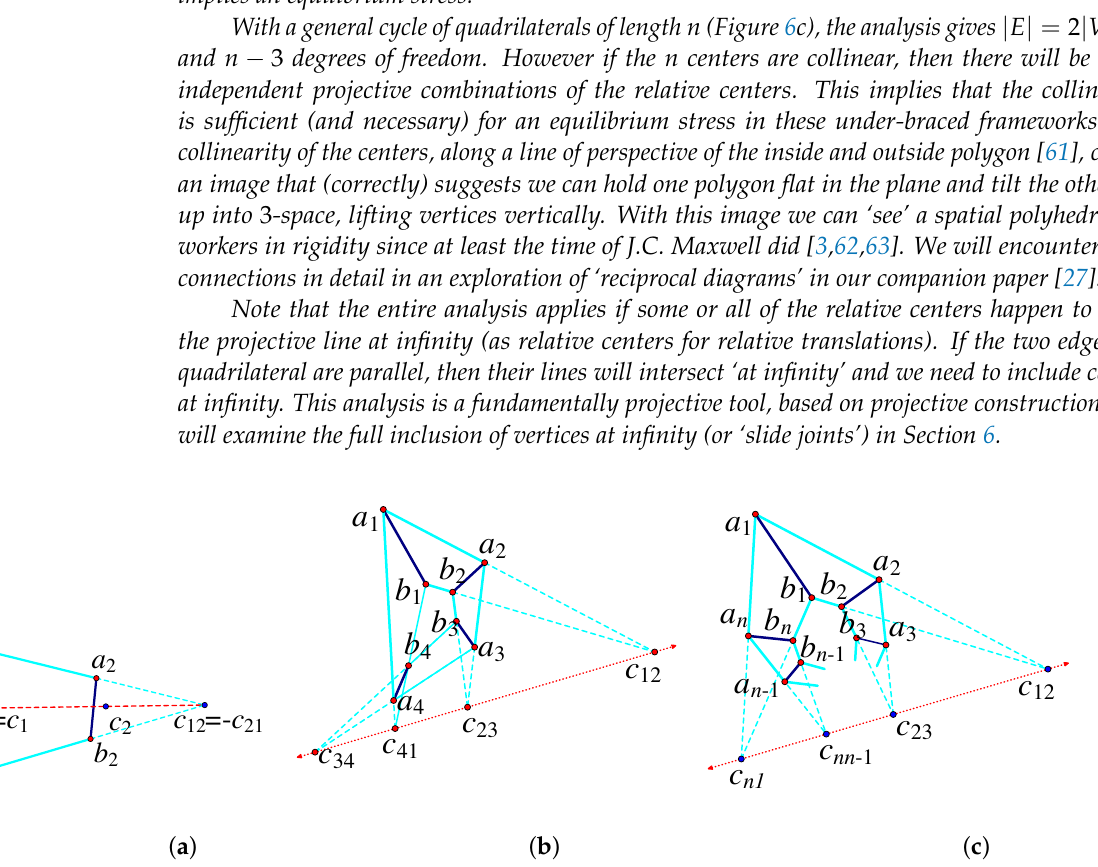
Figure 6. Each plane quadrilateral has a relative center of motion of opposite edges (how one moves when the other is held still): a multiple of the intersection point of the other two sides ( a ). For a larger ring of quadrilaterals, the collinearity of these relative centers will guarantee extra infinitesimal motions ( b , c